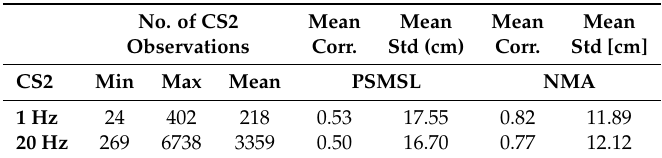
Table 1. Number of available CS2 SARIn observations in CS2 boxes and the overall agreement (mean Spearman’s rank correlation coefficient and mean standard deviation) between CS2 and tide-gauge time series at 20 Norwegian tide gauges.